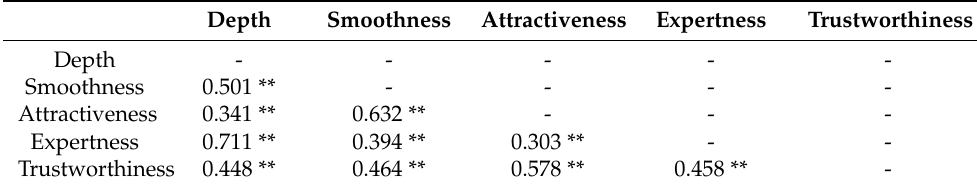
Table 3. Means and standard deviations for the four voice on the dependent variables.